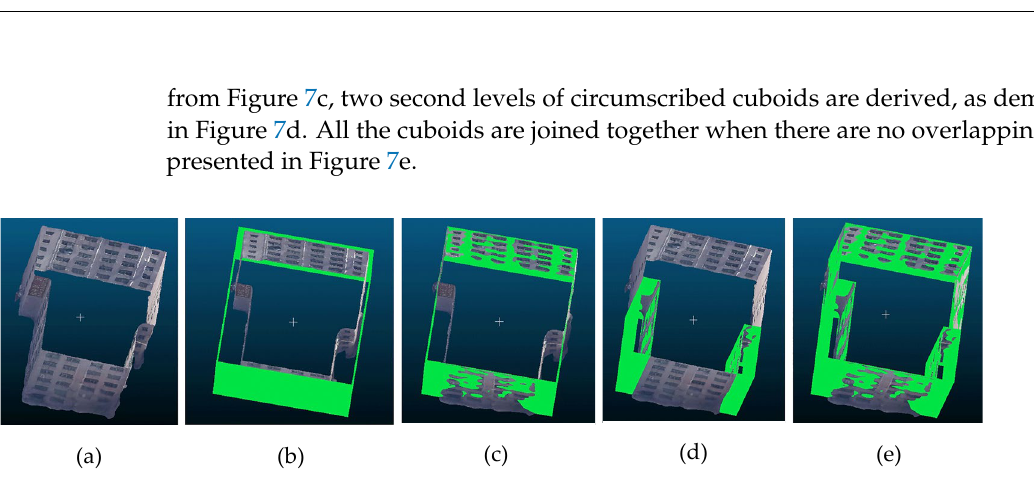
Figure 7. Illustration of the cuboid abstraction processing: ( a ) input of the original photogrammetric mesh model; ( b ) the first fitted cuboid; ( c ) the modification of the first fitted cuboid; ( d ) the second fitted cuboid; ( e ) combined cuboid abstraction result.